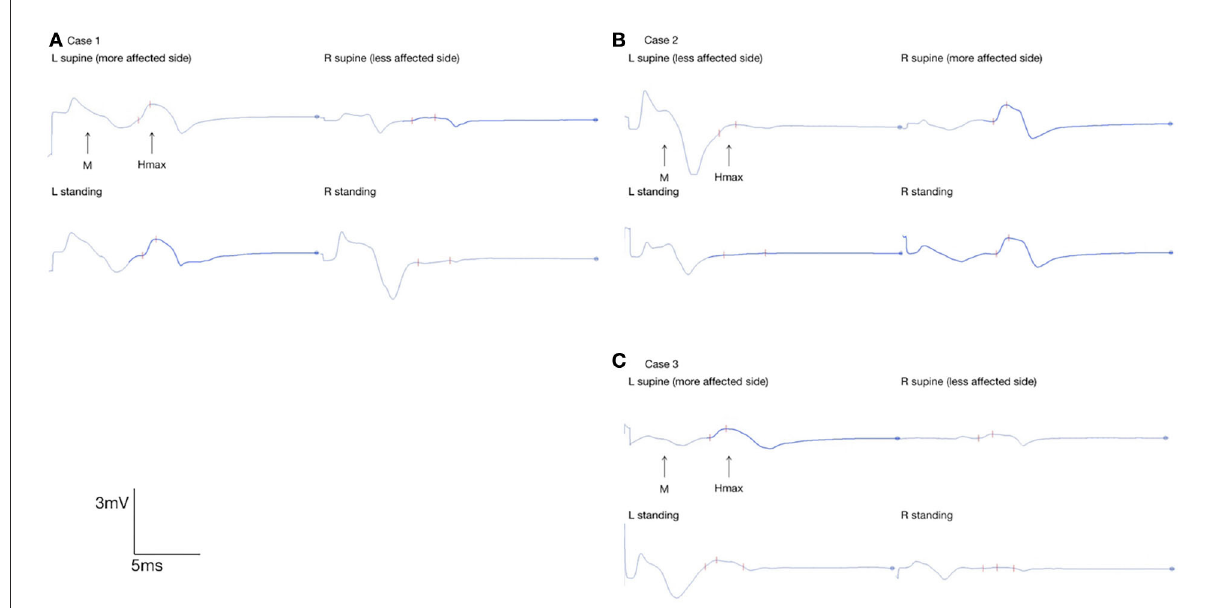
FIGURE2 Flexor carpi radialis H-reflex in bilateral UEs in (A) case 1, (B) 2, and (C) 3; FCR Hmax of the more-affected UE and less-affected UE in the supine position and static standing were marked with red marks on the EMG